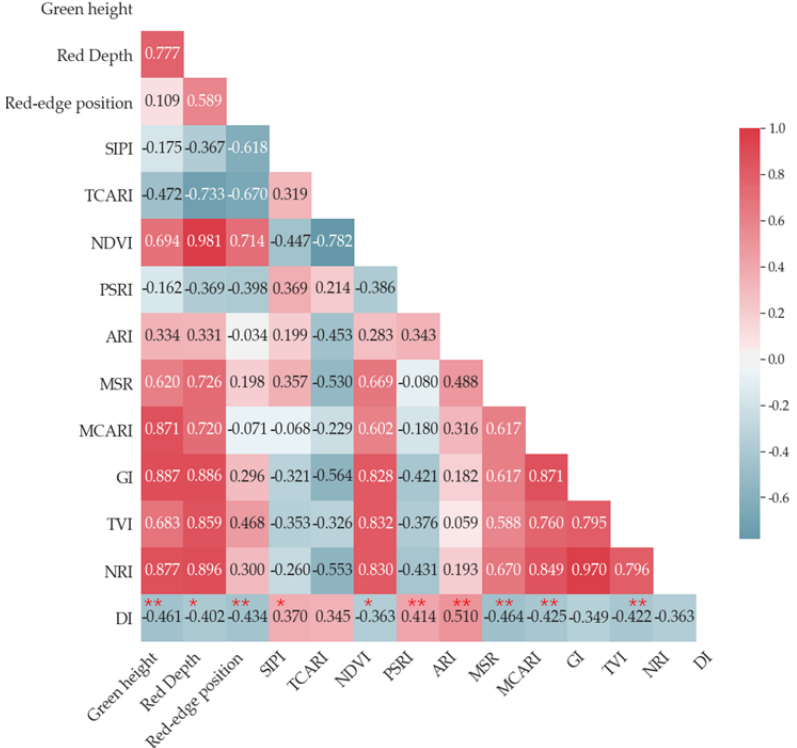
Figure 4. Kendall results among the spectral indices and between each spectral index and disease rate (the last line). The middle part is the Kendall correlation coefficient between the spectral indices of the corresponding row and column. The Kendall and T-test results for the disease rate and each spectral index in the corresponding column are shown in the last row, in which “*” corresponds to the 90% confidence interval and “**” corresponds to the 95% confidence